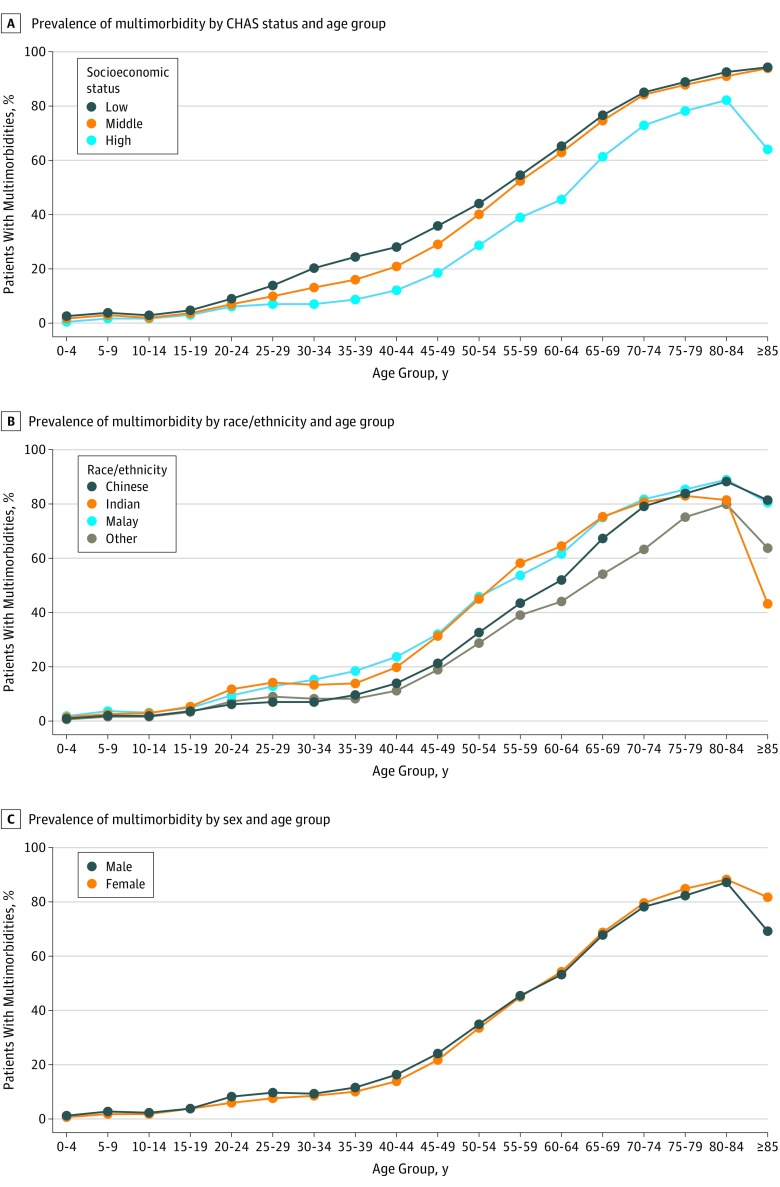
Prevalence of Multimorbidity by Age, Varied by Socioeconomic Status, Race/Ethnicity, and SexLow socioeconomic status indicates a monthly household income of 1100 Singapore dollars (SGD) and below (for households with income), middle socioeconomic status indicates a monthly household income of 1101 to 1800 SGD (for households with income), and high socioeconomic status indicates a monthly household income of more than 1800 SGD (for households with income). (Exchange Rate as of December 31, 2016, is 1 US dollar = 1.4465 SGD). CHAS indicates Community Health Assistance Scheme.